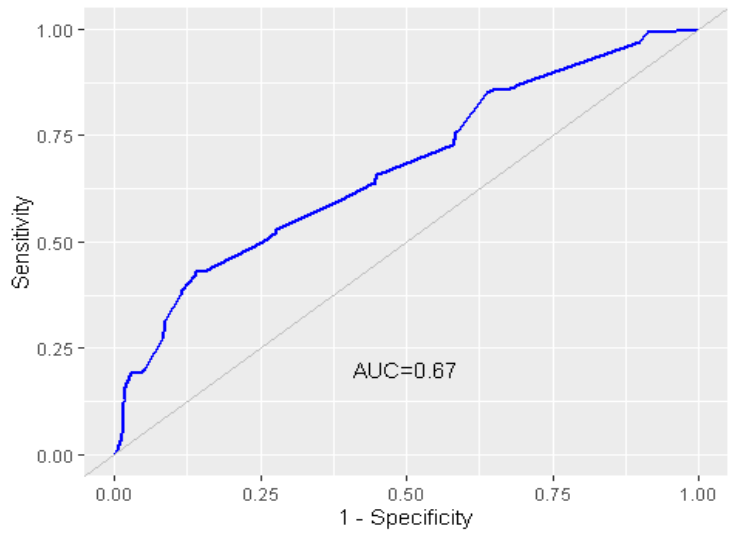
Figure 2. Predicted probabilities of final model based on the Receiver Operating Characteristic (ROC)